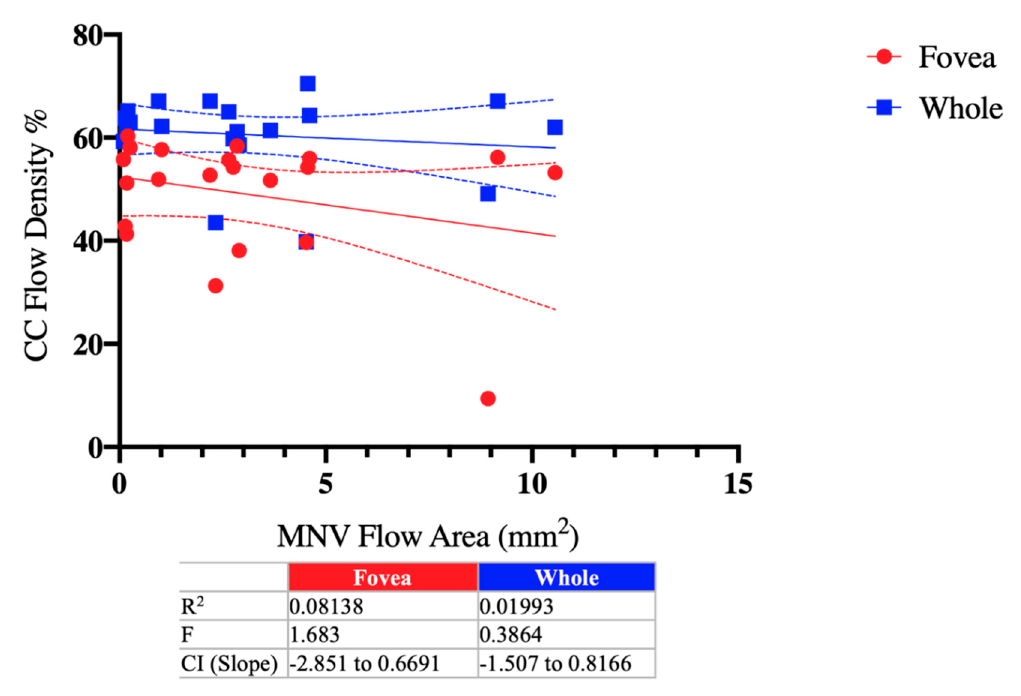
Figure 6. Linear regression between MNV flow area (mm 2 ) and choriocapillaris flow density (%) in ae-AMD eyes. No statistical correlation was observed.